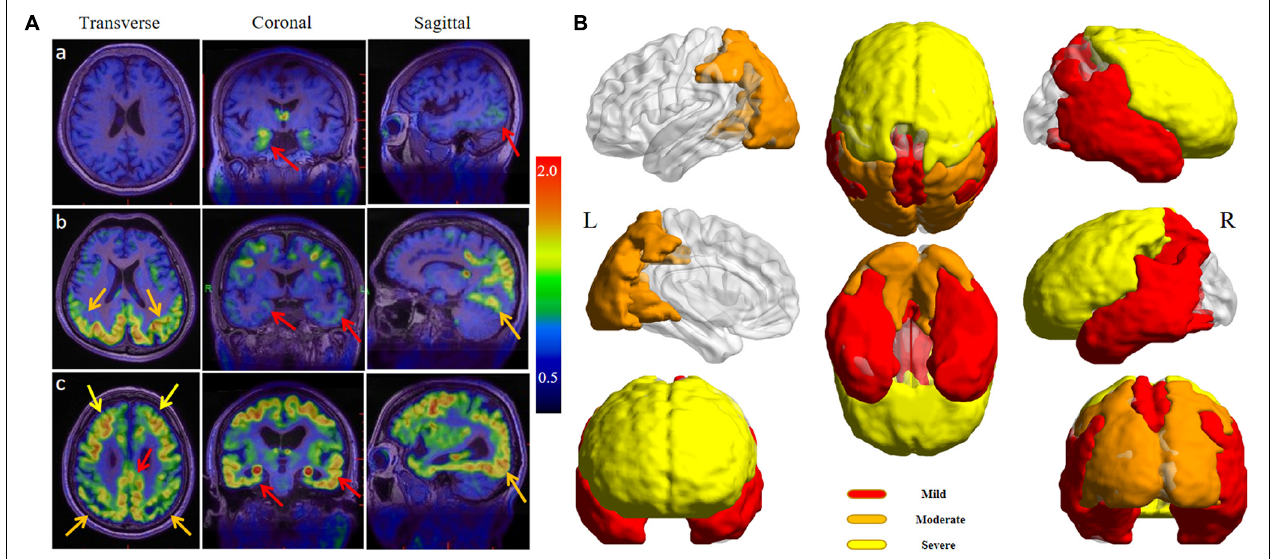
FIGURE 1 | (A) 18 F-APN-1607 PET/MR fusion images of three AD patients with varying degrees. (a) A 67-year-old woman complained of memory decline for 2 years (MMSE = 26, mild group), and the uptake of 18 F-APN-1607 could be seen in the hippocampus and posterolateral temporal cortex (red arrows). (b) A 54-year-old man was with progressive memory loss for 5 years and aggravated for 2 years (MMSE = 18, moderate group), and the high uptake was expanded to the parietal and occipital lobes (orange arrows). (c) A 67-year-old man suffered from memory loss for 7 years and self-care disabled for 6 months (MMSE = 5, severe group), and high uptake had been spread to the whole brain including the frontal lobe (yellow arrows). (B) The full-view sketch map for expanding the tau deposits according to the 18 F-APN-1607 PET. The deposition was started from the medial and lateral temporal lobes, posterior cingulate gyrus (PCG), and precuneus (red areas), then spread to the parietal and occipital cortex (orange areas), and finally affected the frontal lobe (yellow areas). L means left and R means